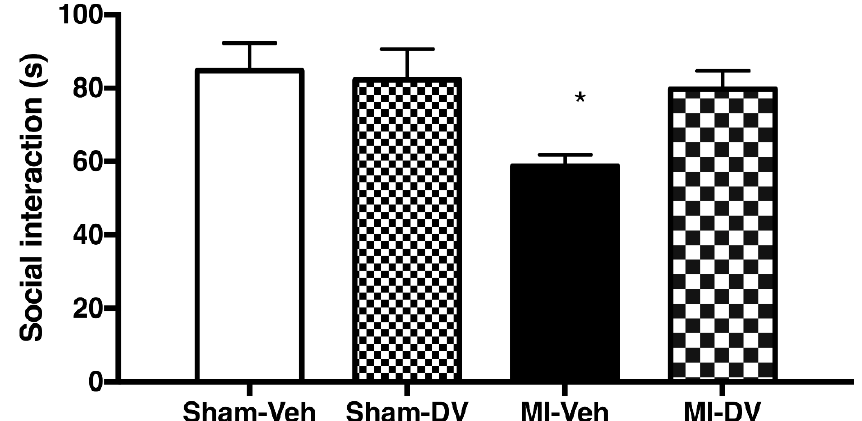
Figure 1. Social interaction. MI rats treated with the vehicle interacted less with other rats than Sham rats treated with the vehicle. MI rats treated with DV performed at the same level as sham rats treated with the vehicle or with DV. n = 10–18/group. * p < 0.05. MI: myocardial infarction; Veh: vehicle; DV: Desvenlafaxine.